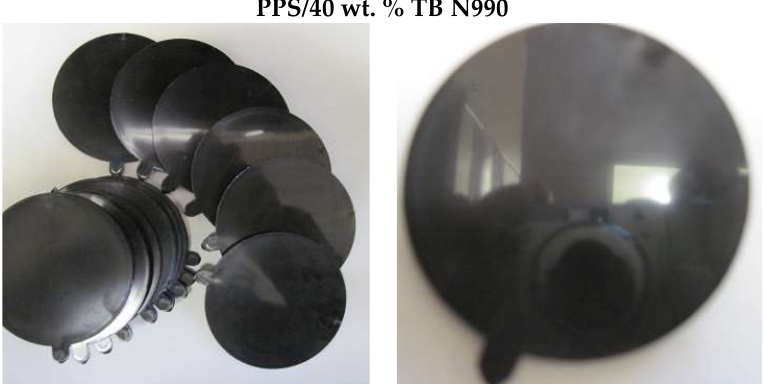
Figure 9. Physical aspect of injection molded specimens based on PPS/40 wt. % TB N990 composite.